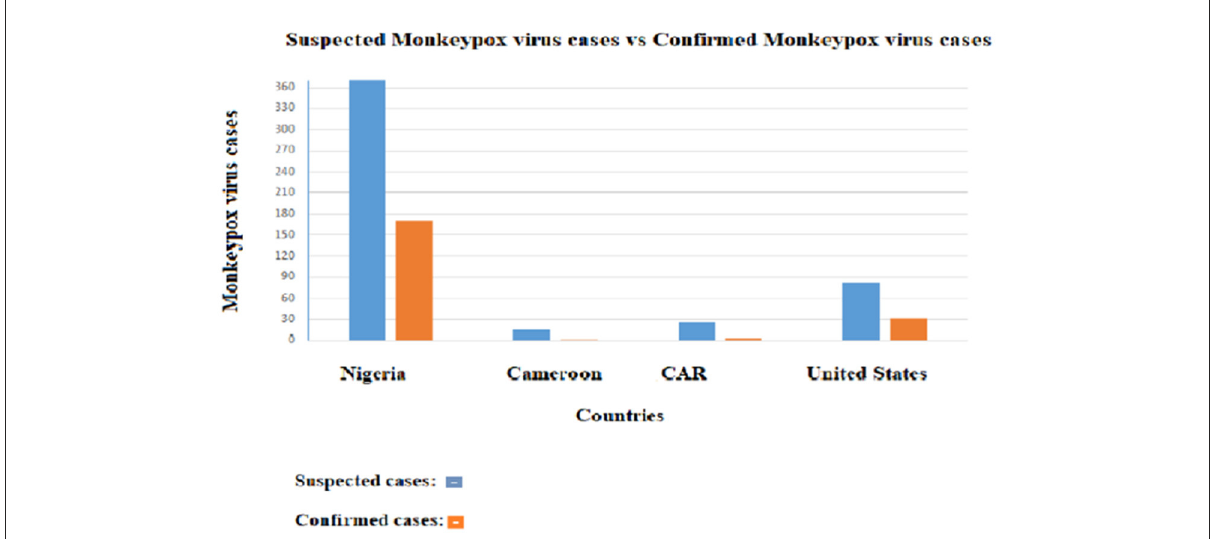
FIGURE4 Distribution of suspected Monkeypox cases and confirmed cases in four countries. The orange bars represent the confirmed cases and the blue bars the suspected